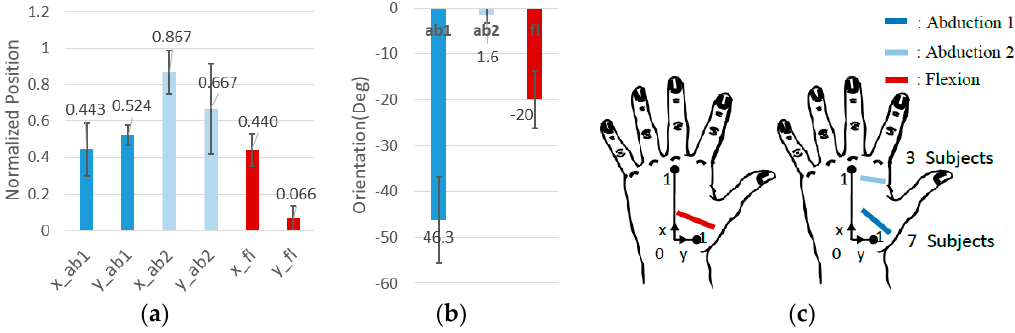
Figure 7. Average optimal CMC sensor position and orientations (10 subjects): ( a ) average optimal CMC-joint angle sensor positions; ( b ) average optimal CMC-joint angle sensor orientations; ( c ) illustration of the optimal CMC-joint angle sensor location. The abduction sensor had two distinct location trends. The optimal sensor location of seven subjects was across the adductor pollicis (mean: x = 0.442, y = 0.524, orientation = − 46.3°), and the optimal sensor location for three subjects was across the 2nd metacarpal bone (mean: x = 0.867, y = 0.667, orientation = − 1.7°).